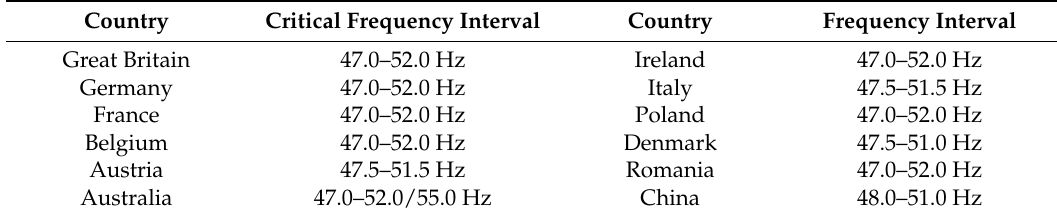
Table 4. Critical frequency variation intervals